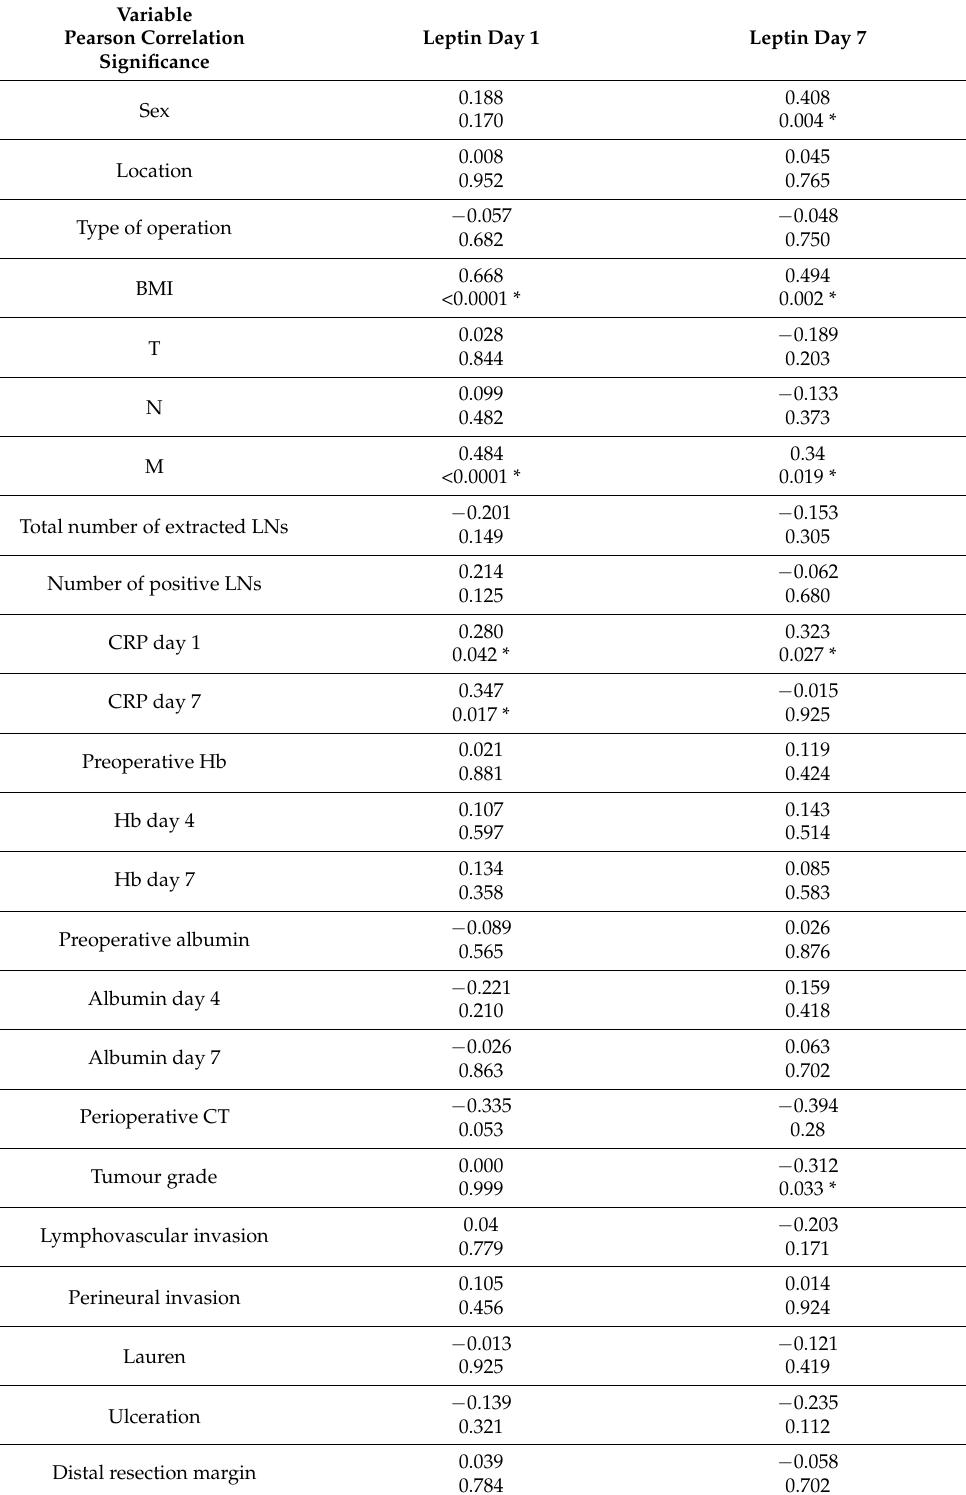
Table 2. Correlations between leptin and clinicopathological predictors: Correlation